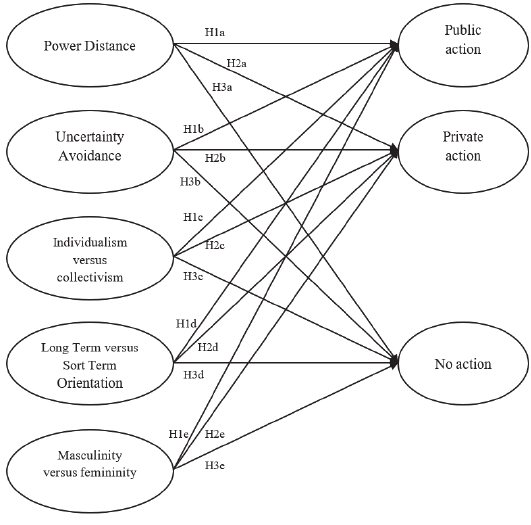
Fig. 1. Conceptual